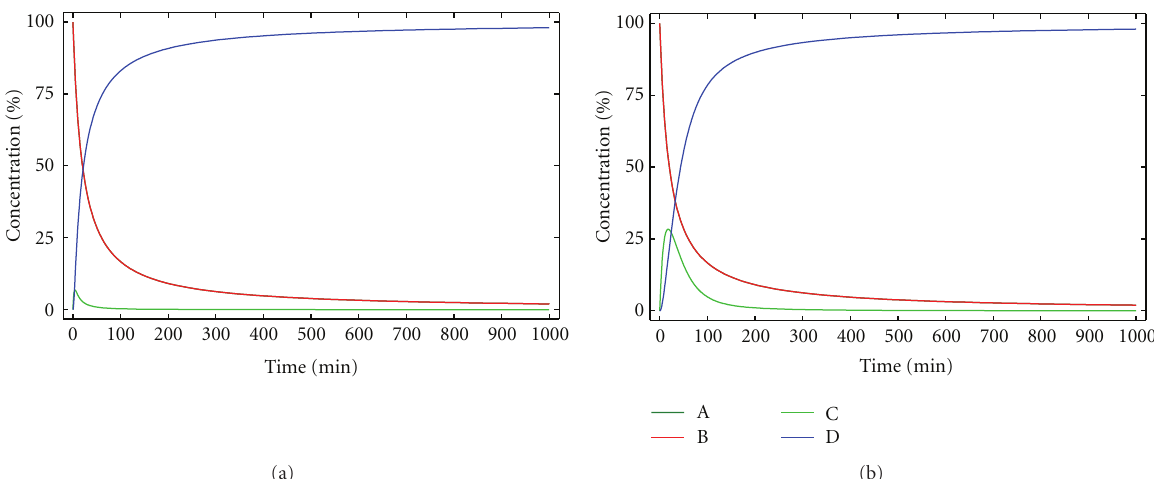
Figure 1: Concentration of the reactants, products, and reaction intermediate versus time for kinetic model 1. [A] 0 = [B] 0 = 0 . 005 M, k = 10 M − 1 min − 1 and (a) k = 0 . 5 min − 1 , (b) k = 0 . 05 min − 1 . 1 2 2 In (1), A is the bis(amidoamine), B is the dihalide, C